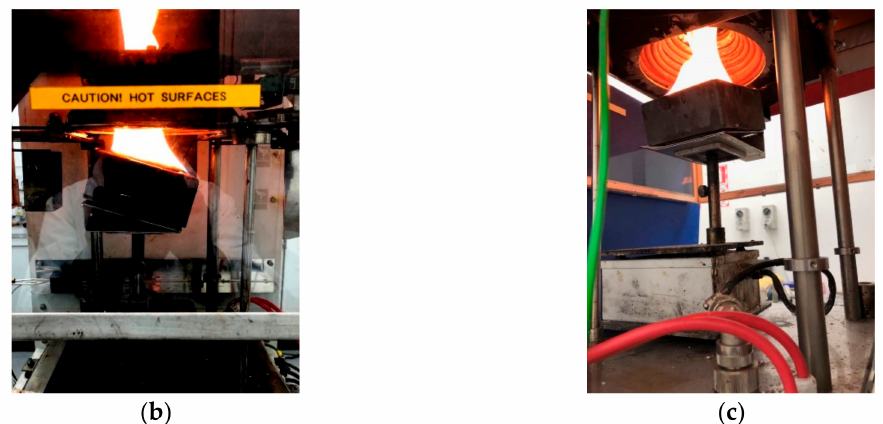
Figure 1. ( a ) Schematic 2D diagram of sample orientations relative to horizontal (i.e., heat flux normal) direction from the cone heater ( b ) Cone calorimeter experimental setup for an inclined sample orientation (15 ◦ orientation)—front view, and ( c ) side